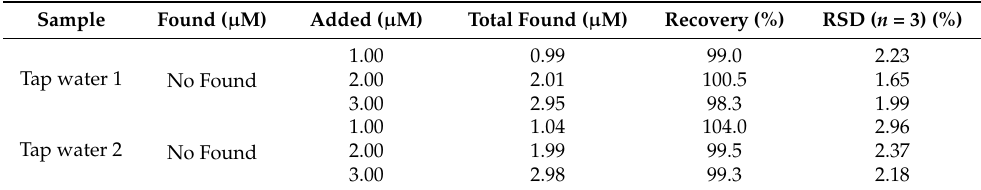
Table 2. Determination of Cu 2+ in tap water samples ( n =